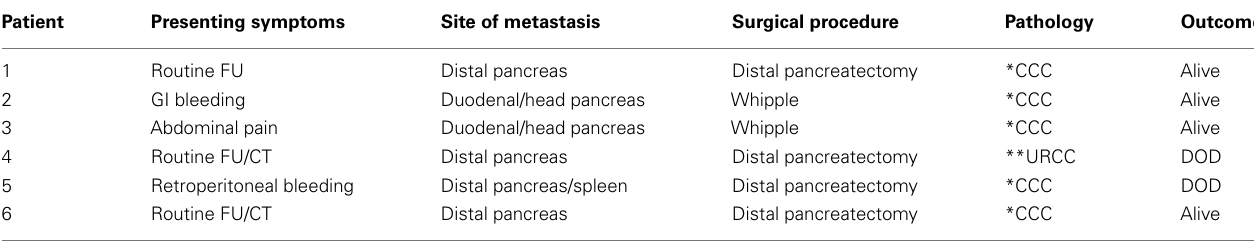
Table 2 | Clinical pathologic characteristics